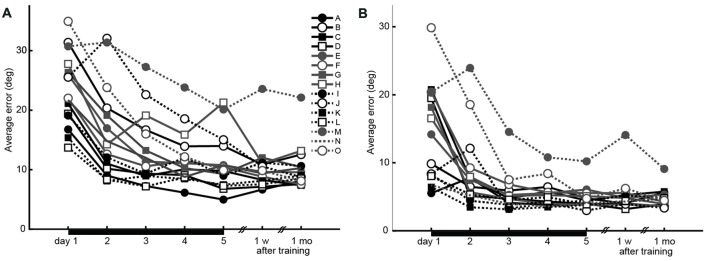
Performance changes during the experiment (15 participants). (A) Initial errors recorded 150 ms after movement onset, as the index for accuracy of feed-forward motor control. (B) Endpoint errors recorded at movement offset, as the index for the combination of feed-forward and feedback motor control accuracies. Black horizontal bars from days 1 to 5 indicate the training period.